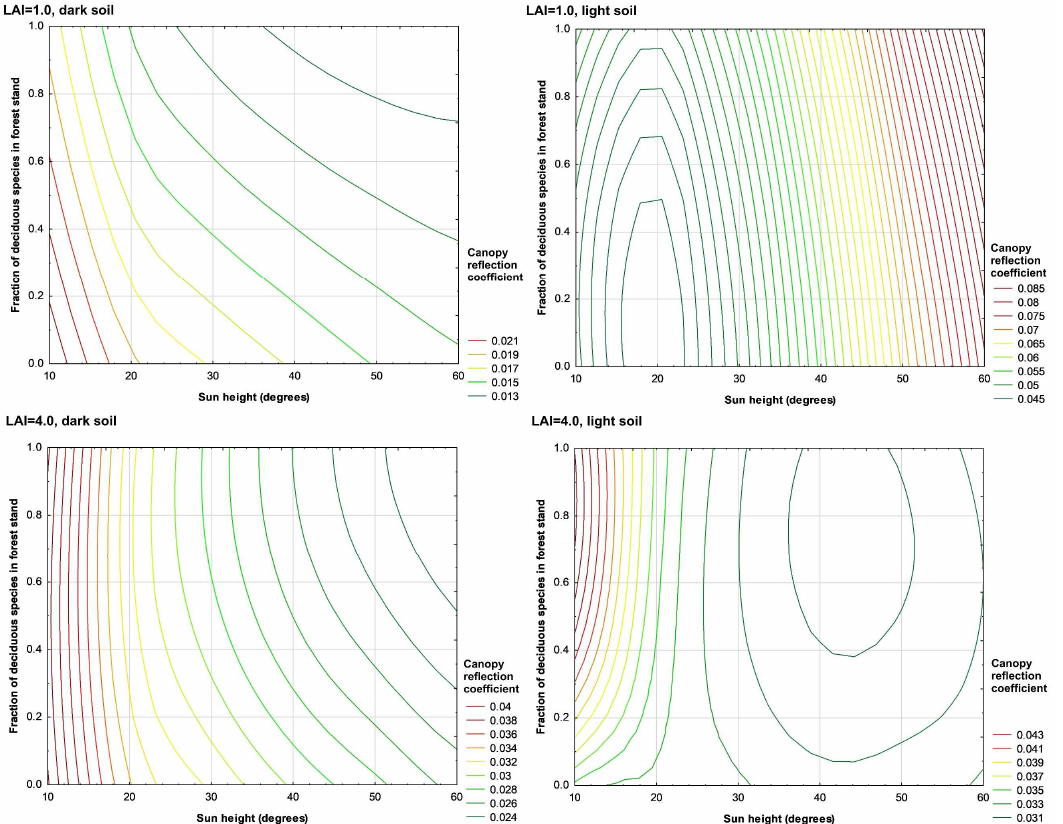
Figure 7. Dependence of canopy albedo on sun elevation and the fraction of deciduous and coniferous tree species in a mixed forest stand of different stock densities (LAI = 1 and 4 m 2 m − 2 ). All modeling experiments were completed for dark ( (cid:36) s = 0.01) and light ( (cid:36) s = 0.20)